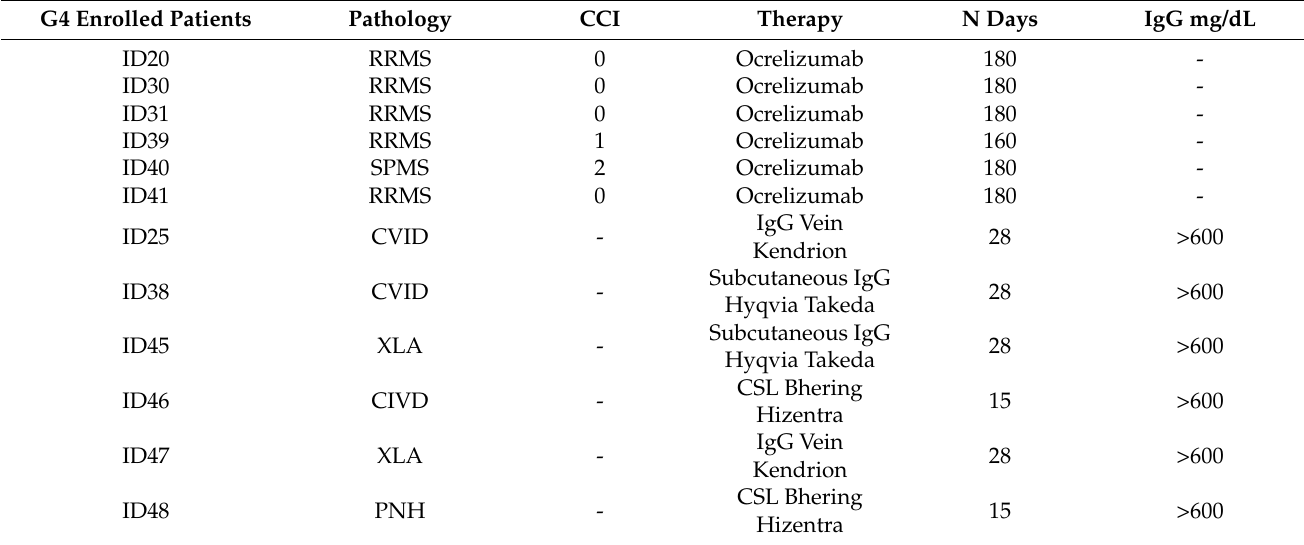
Table 2. Clinical and therapeutic characteristics of G4 enrolled